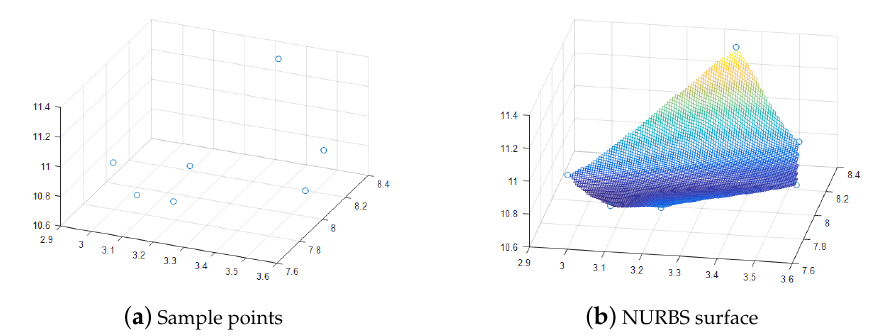
Figure 3. NURBS surface reconstruction based on sample